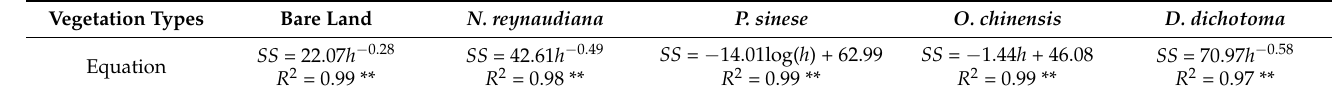
Table 7. Equation of the shear strength of the root–soil complex ( SS ) with soil layer ( h ). Vegetation Types Bare